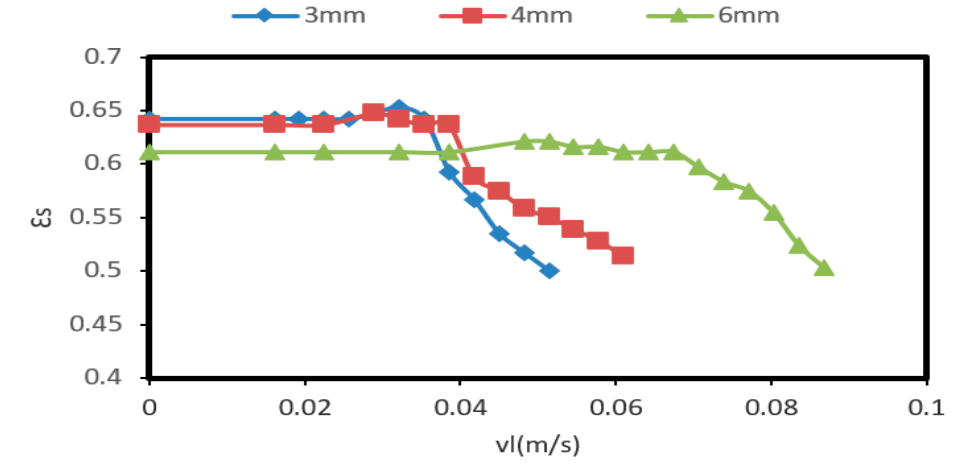
Figure 6. Variation solid holdup with liquid velocity for various particle diameters.